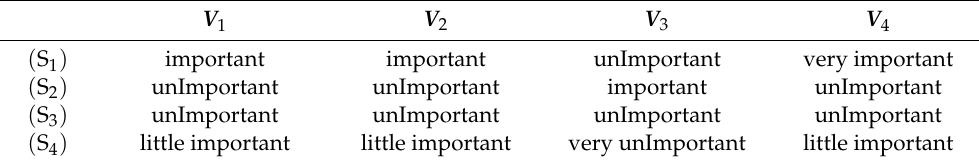
Table 1. The robot stages on the importance of degrees using Hedge Algebras.